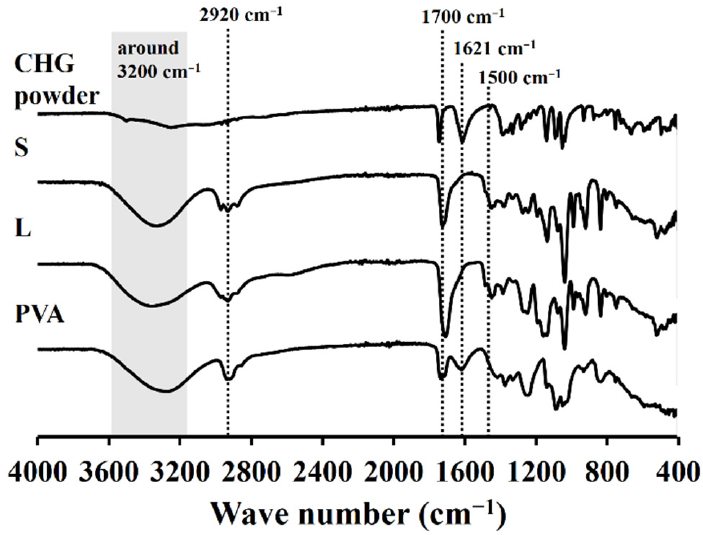
Figure 3. FTIR spectra of CHG powder and film.